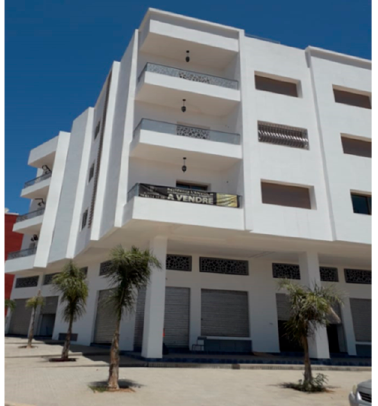
Figure 7. The building co-ownership, object of the case study.